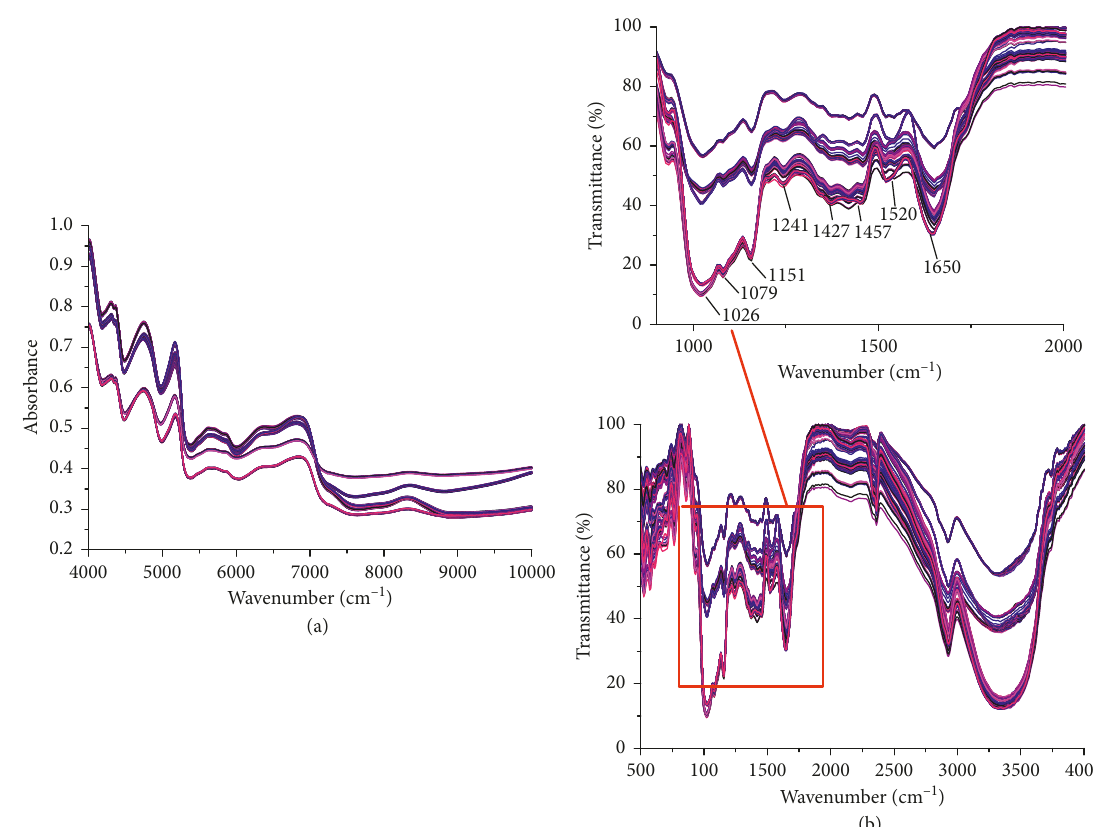
Figure 2: Raw NIR (a) and MIR (b) spectra of two kinds of Corydalis yanhusuo W. T. Wang, Corydalis decumbens (Thunb.) Pers, Typhonium flagelliforme (Lodd.) Blume, and Dioscorea opposita